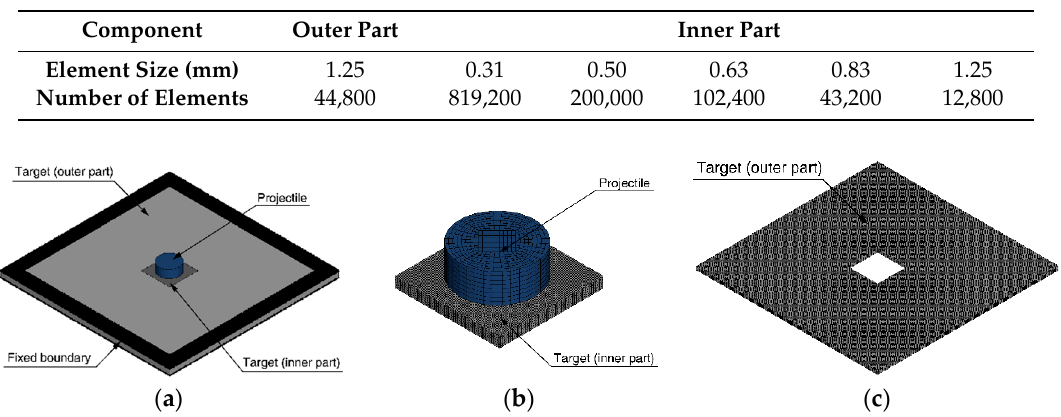
Table 6. The number of elements for 10 mm plate model.